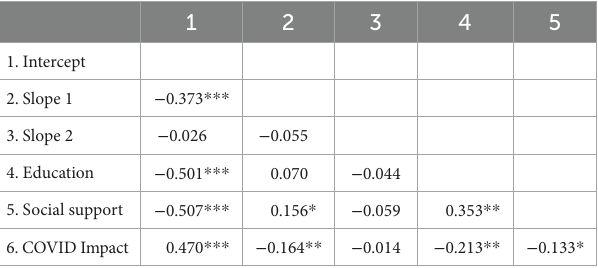
TABLE 4 Correlations between intercepts, slopes and predictors.